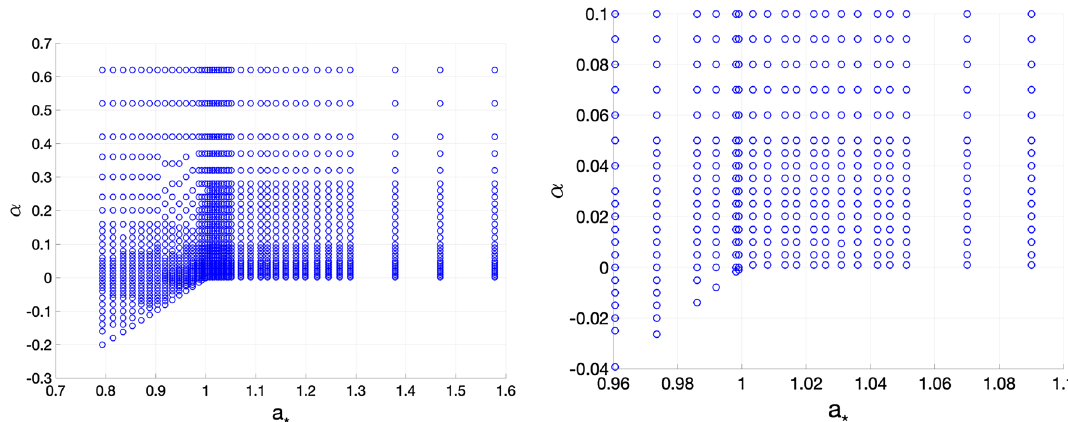
Fig. 2 The left panel shows the grid points in the FITS file for the spin parameter a ∗ and the deformation parameter α . The right panel zooms in on the region near a ∗ = 1 and α = 0